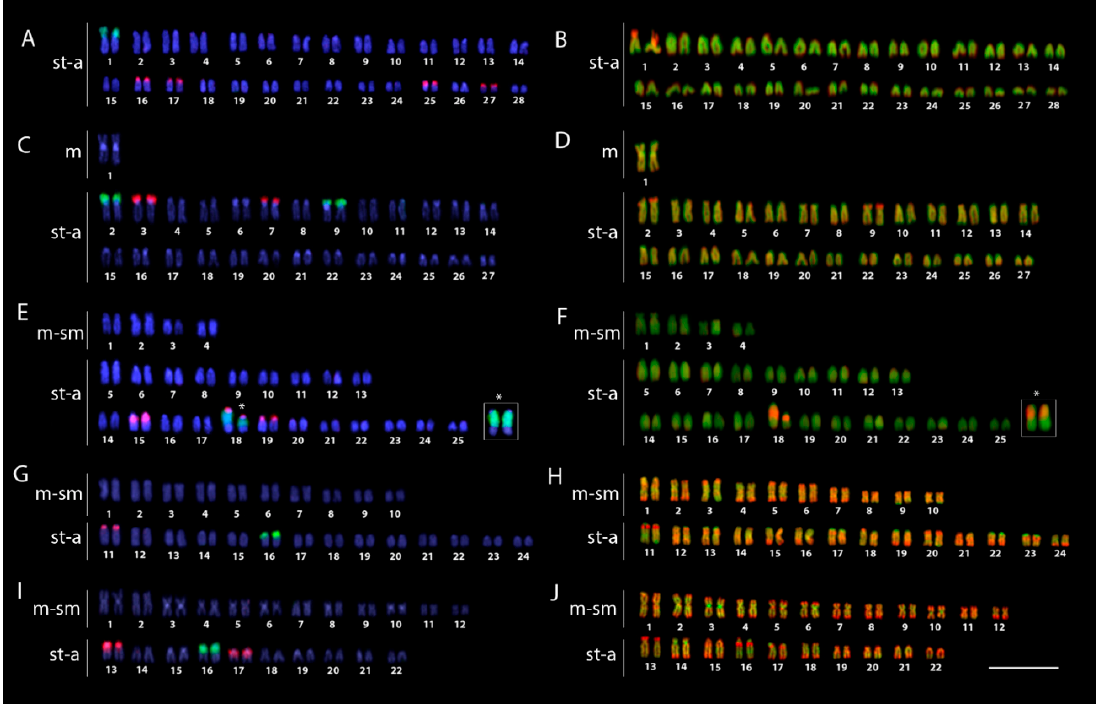
Figure 4. Karyotypes of the silver arowana Osteoglossum bicirrhosum ( A,B ), black arowana Osteoglossum ferreirai ( C,D ), Asian arowana Scleropages formosus ( E,F ); northern saratoga Scleropages jardinii ( G,H ) and southern saratoga Scleropages leichardti ( I,J ) arranged from chromosomes labeled with 5S rDNA (red) and 18S rDNA (green) probes after a dual-color FISH ( A,C,E,G,I ) and after CMA 3 /DAPI staining ( B,D,F,H,J ). In boxes, the different forms of the 18th chromosome pairs of Asian arowana with their heteromorphic 18S rDNA sites and CMA 3+ signals. Bar = 5 µm.